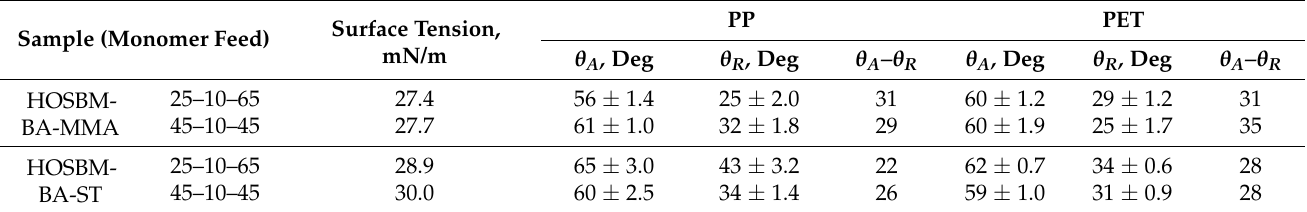
Table 3. Contact angle hysteresis of HOSBM-based latexes on PP and